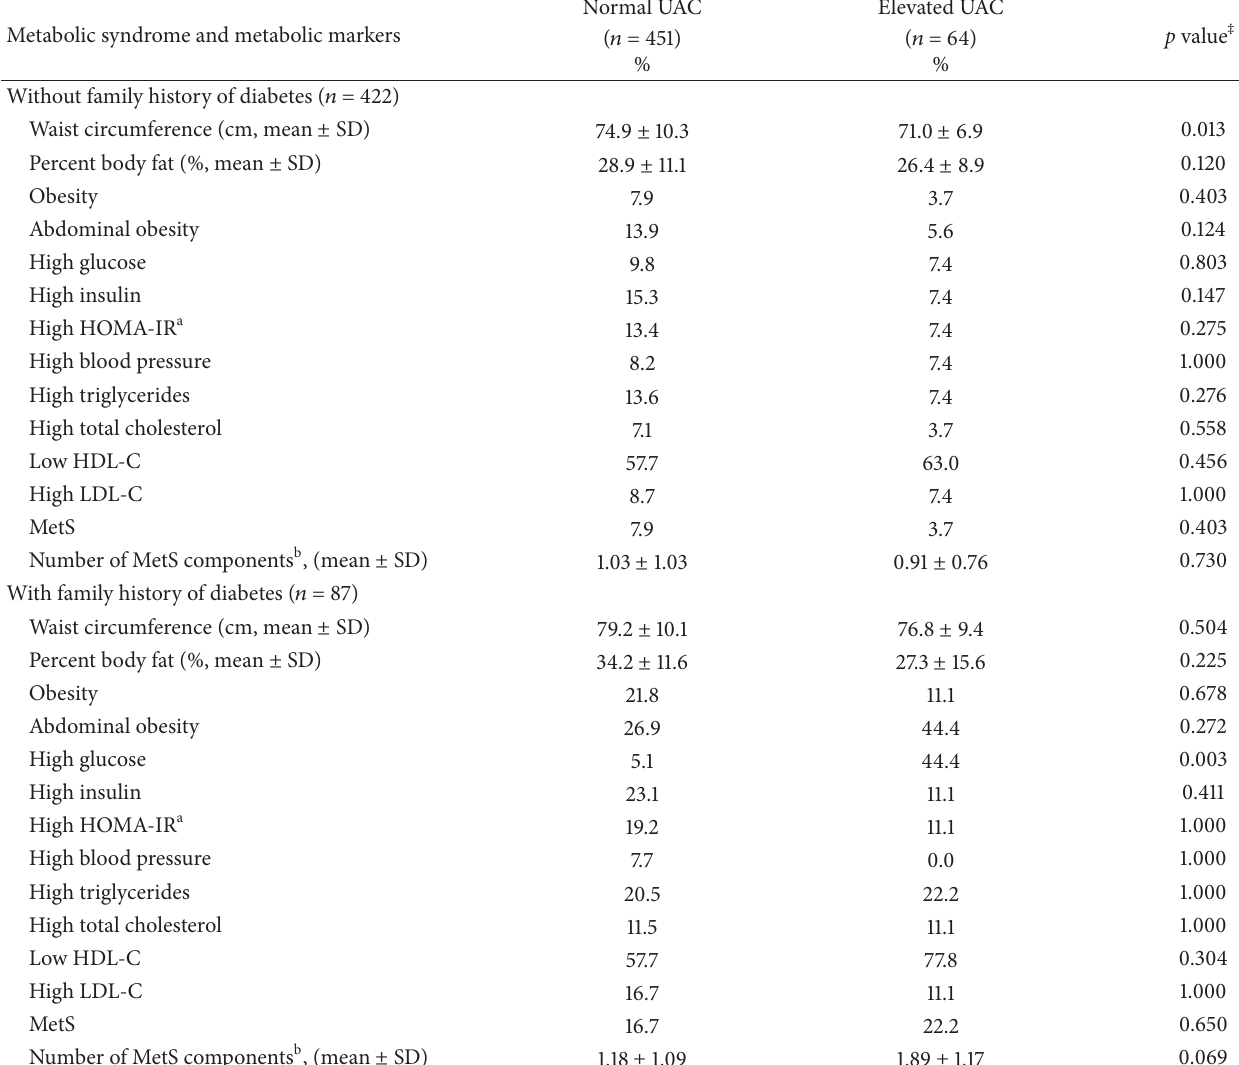
Number of MetS components b , (mean ±